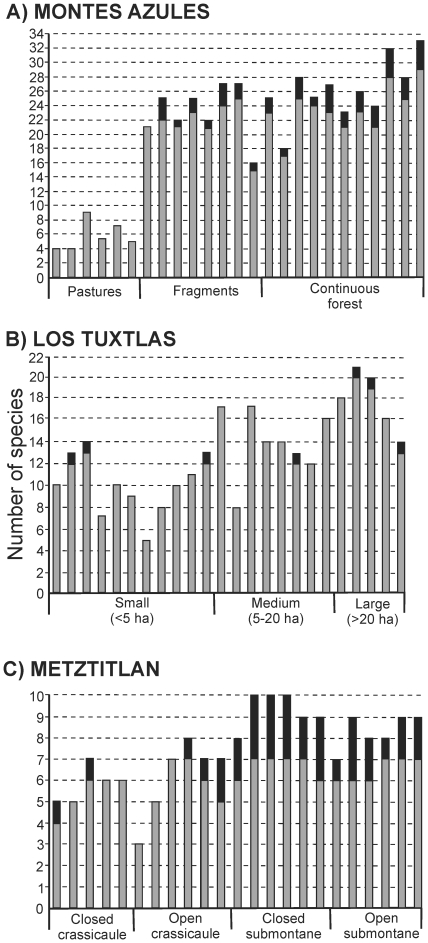
Functionally singular and redundant species in each local
community.The complete bar indicates the total number of species in each community,
the white segment corresponds to the functionally singular species and
the black segment to the redundant species. (A) Montes Azules, (B) Los
Tuxtlas and (C) Barranca de Metztitlán.